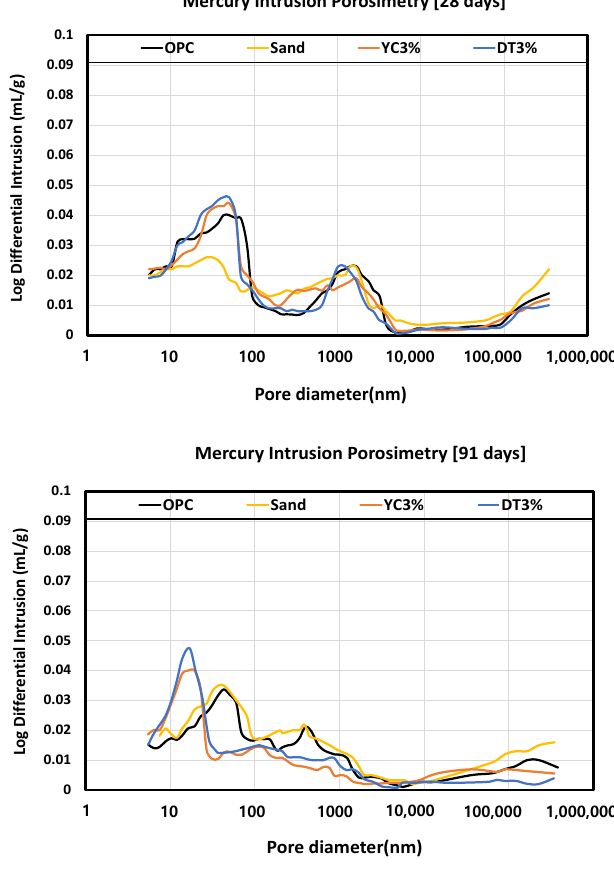
Figure 13. Measurement of MIP.